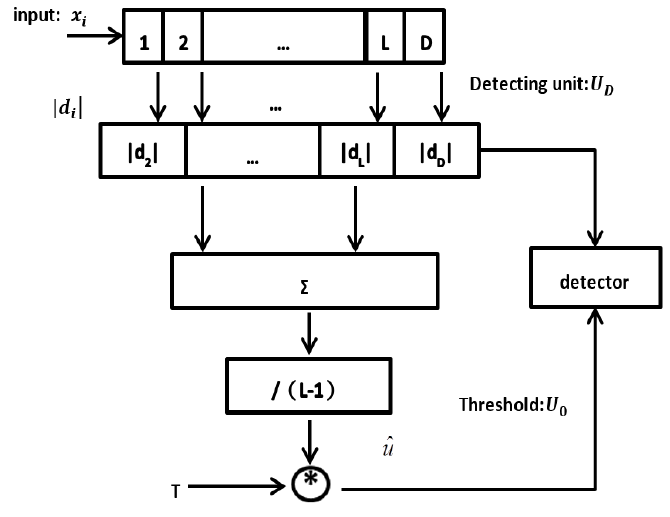
Figure 4. Model of the CR-CFAR method.